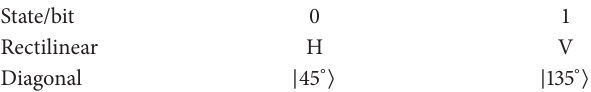
Table 1: Polarization states for